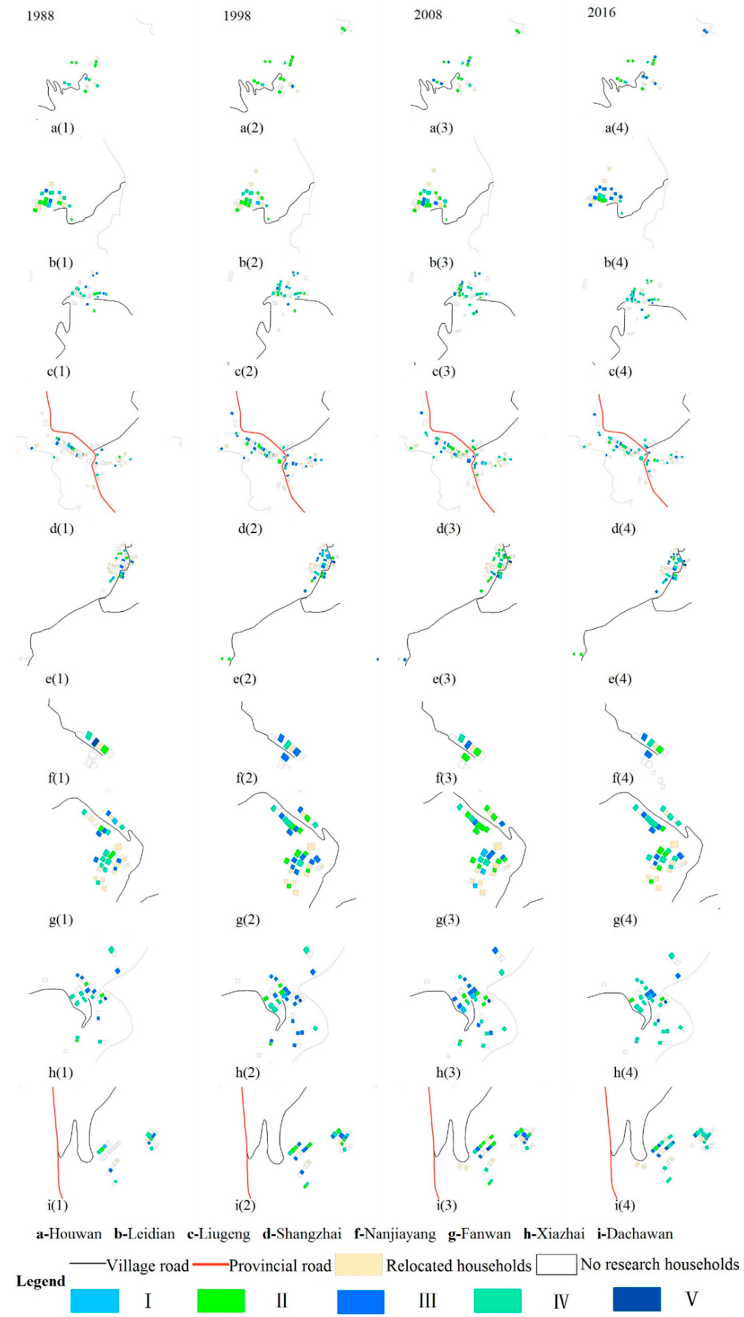
Figure 5. Spatial distribution of different types of households in 1988–2016.